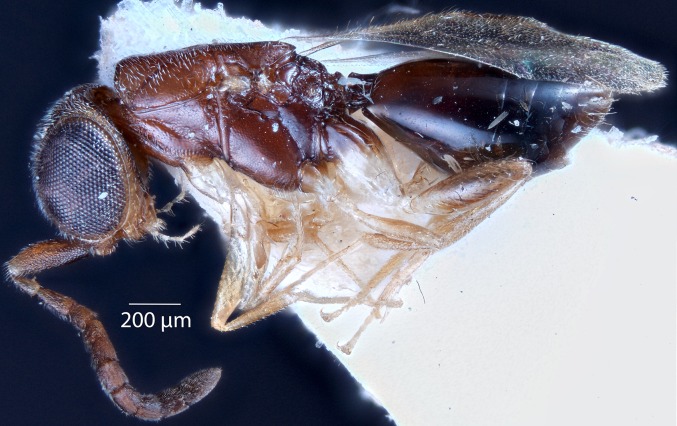
Brightfield image showing the lateral habitus of Conostigmus babaiax
Dessart, 1997.